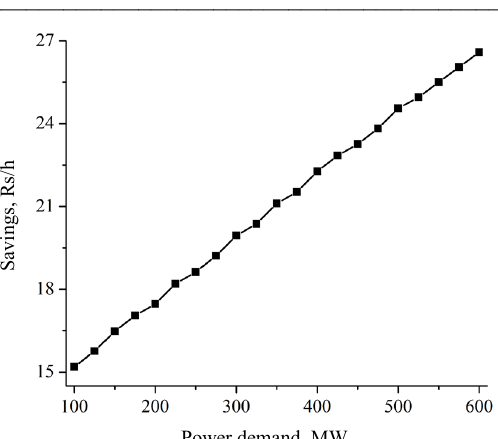
Fig. 10. Power demand vs